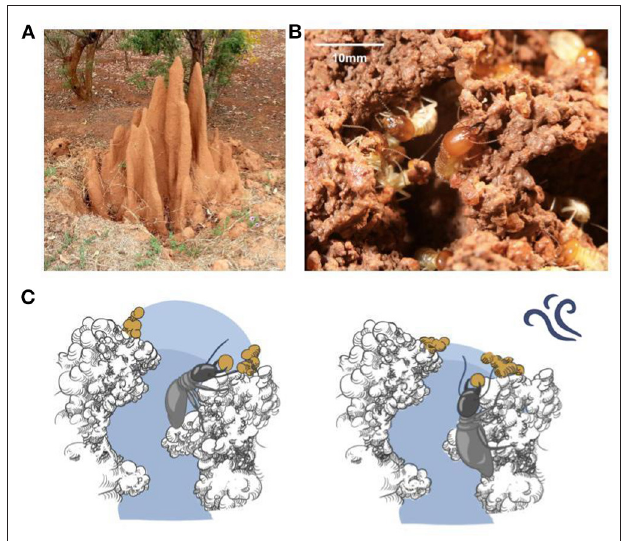
FIGURE 1 | Mound-building termites and the humidity template hypothesis. (A) An Odontotermes obesus mound in India, ∼ 1.2 m tall; mounds of other species can be much larger and have been reported at over 8 m ( McFarlan and McWhirter, 1991 ). (B) Individual termites building at the end of a tunnel at the mound surface. (C) The hypothesis is based on agents depositing material at the edge of a region of elevated humidity (light blue shading), which extends a short way into the external environment when air is still, and terminates at the tunnel end when disturbed, leading to the tunnel being extended in the first case and closed off in the second, as described in Bardunias et al. (2020).